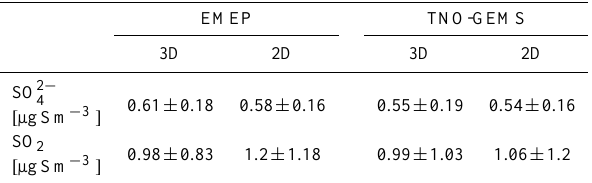
Table 6. Comparison of mean daily concentrations for the year 2000 of SO 2 − and SO 2 with and without vertical distribution of 4 the emissions. Values are averages over all measurement stations (51 stations for SO 2 − , 33 stations for SO 2 ) and their standard 4 deviations. The used measurement stations are described in Table